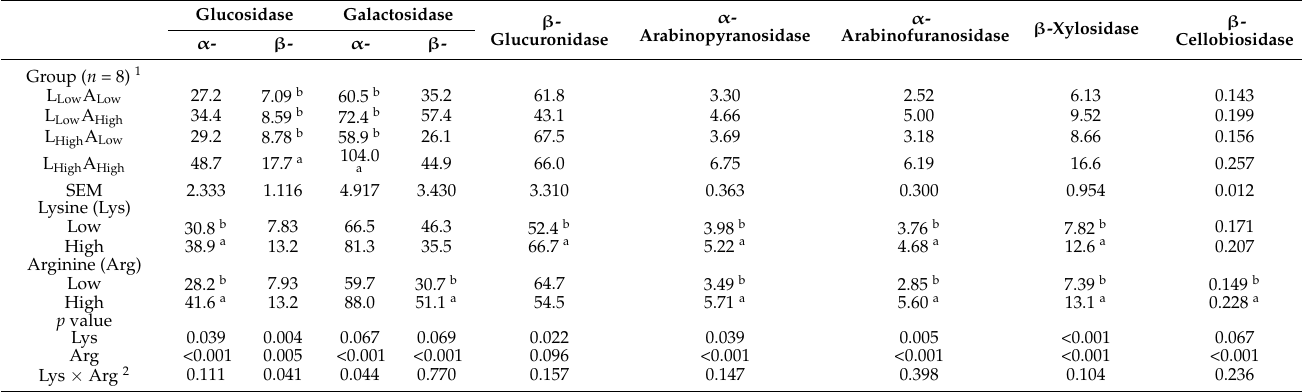
Table 5. Activity of bacterial extracellular enzymes ( µ mol/h/g) in the cecal digesta of experimental turkeys. Glucosidase Galactosidase β -